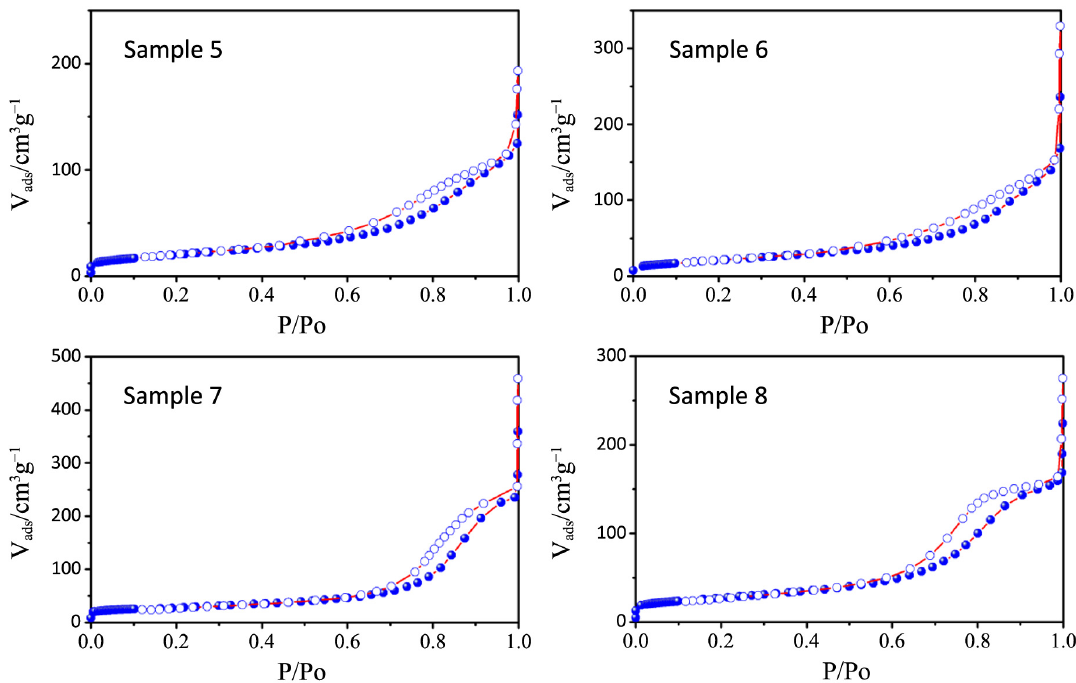
Figure 7. N 2 physisorption isotherms of samples 5–8.